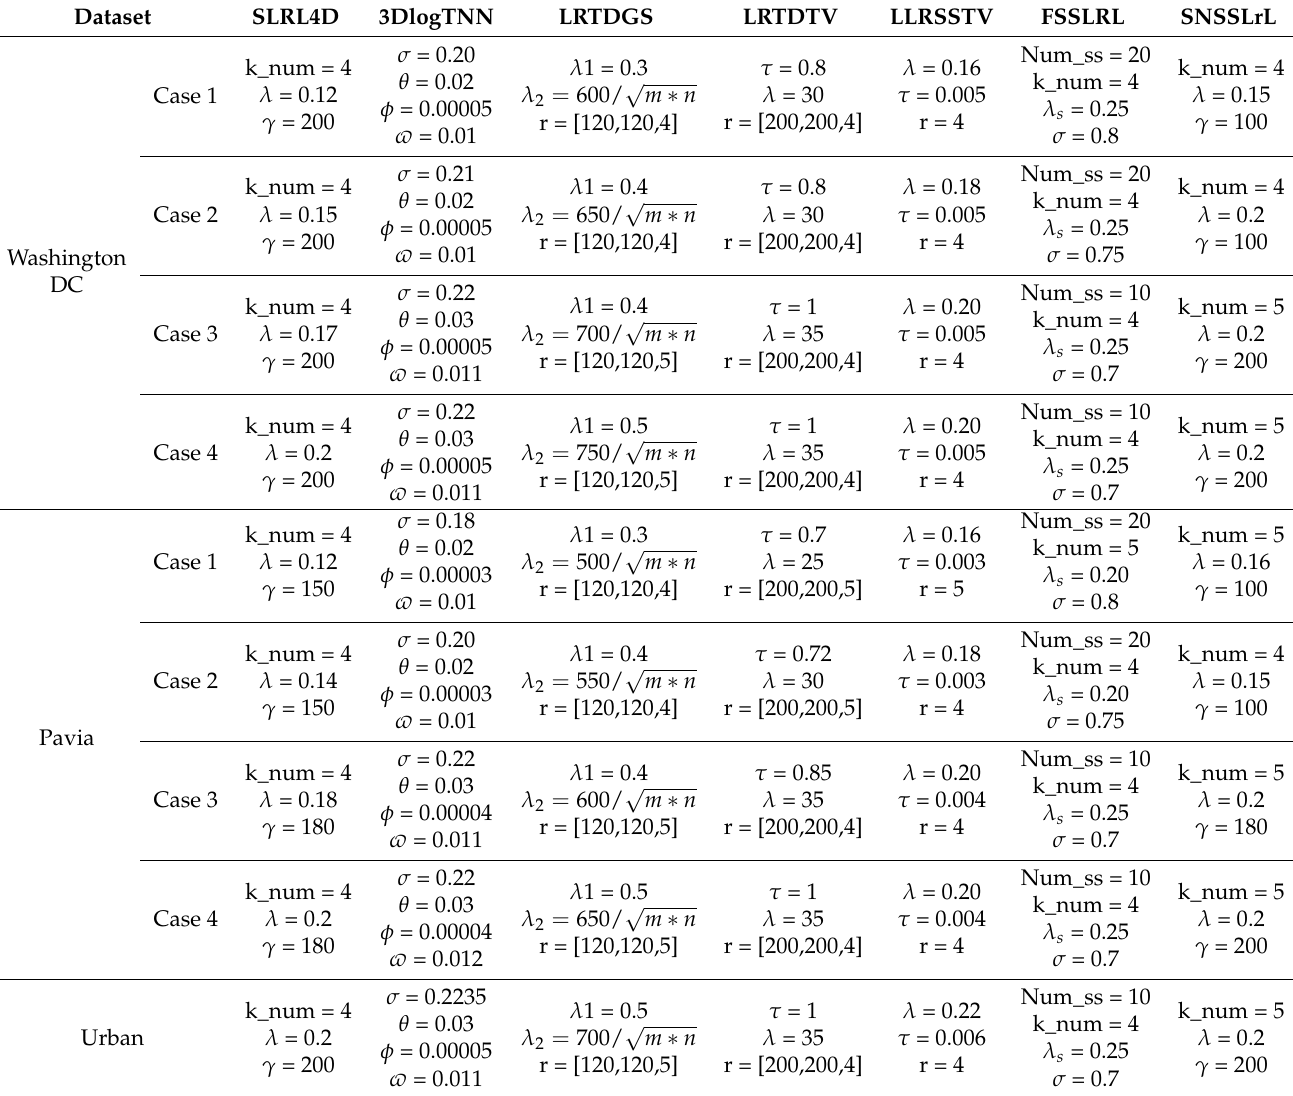
Table 1. Parameter settings for all competing algorithms in both simulated and real